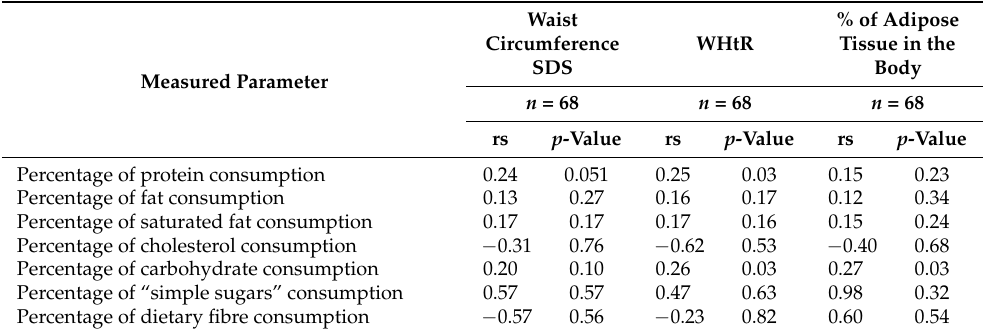
Table 6. The correlation between macronutrient consumption and measured somatic development parameters in children with excess body weight after one-year dietary intervention.